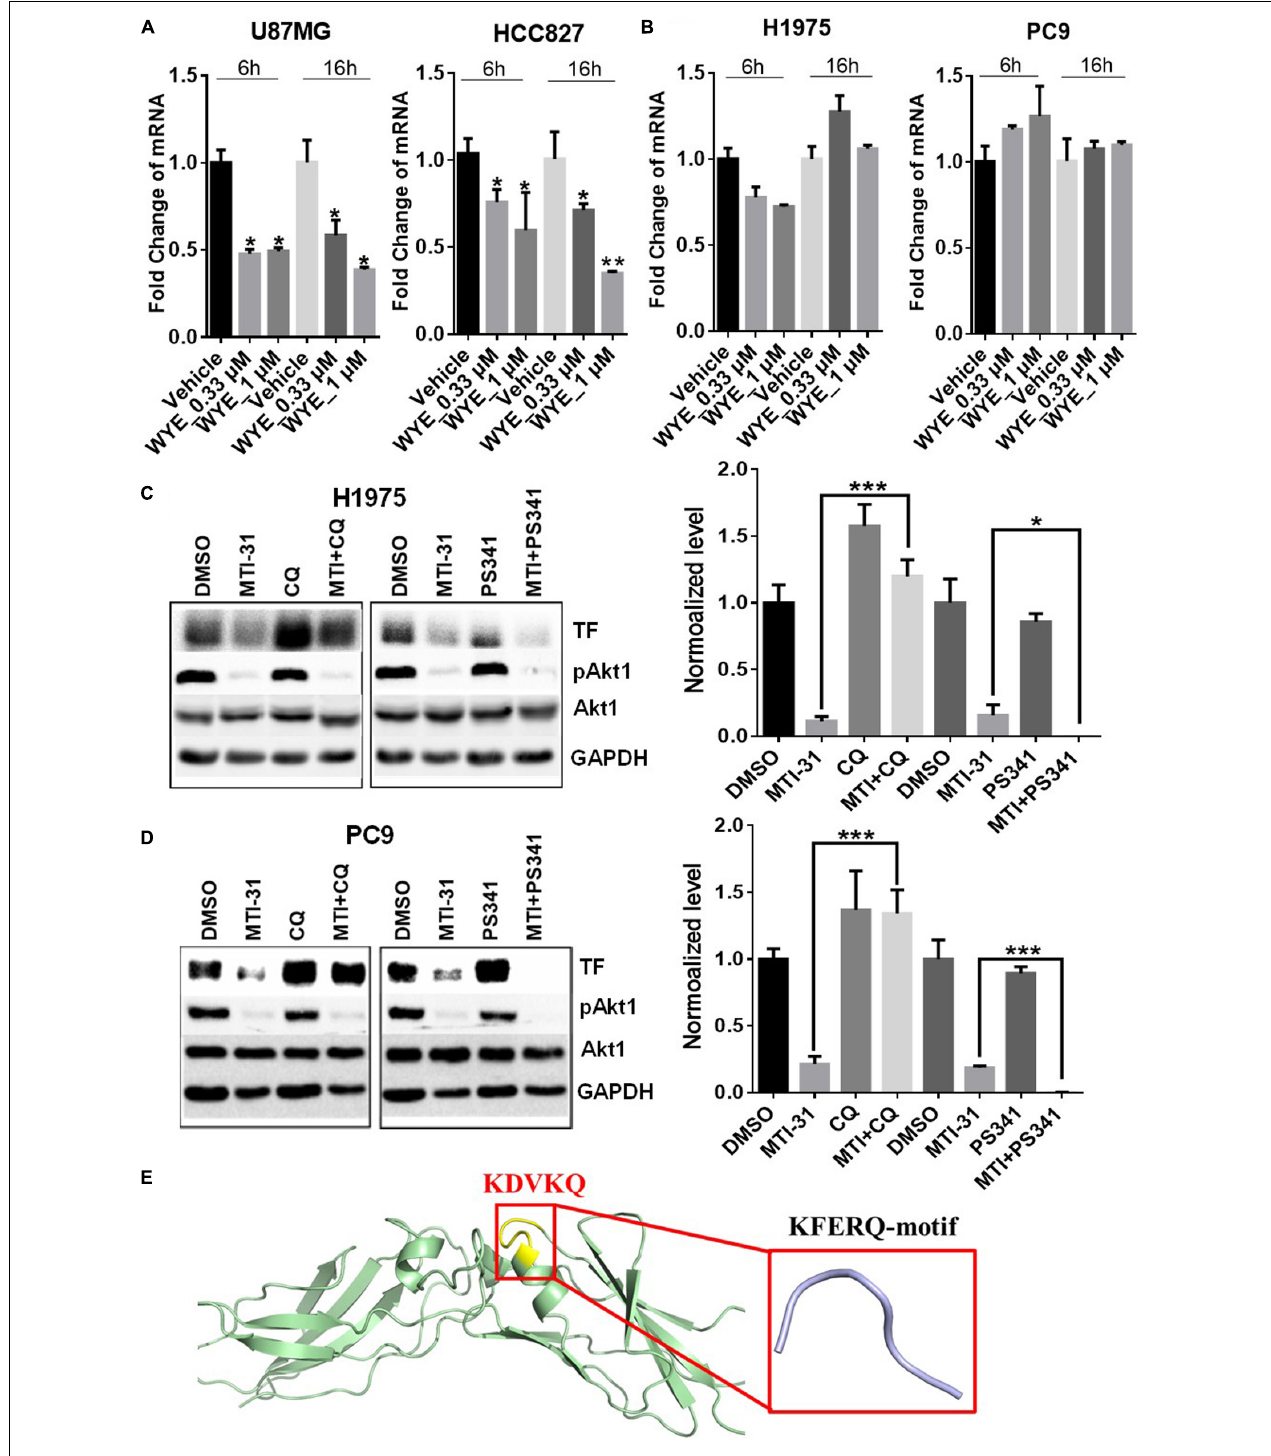
FIGURE 3 | Mechanistic target of rapamycin (mTOR) inhibitor differentially targets TF-mRNA transcription or TF protein degradation in a cellular context-dependent manner. (A,B) U87MG and HCC827 (A) , H1975 and PC9 (B) cells were treated as indicated, subjected to qPCR analysis of TF mRNA as described in section “Materials and Methods.” The relative mRNA levels are shown. (C,D) H1975 (C) and PC9 (D) cells were treated with 5 µ mol/L MTI-31 alone or in combination with 10 µ mol/L CQ or 0.01 µ mol/L PS-341 for 24 h, then immunoblotted (left panels) and quantified (right panels). * P < 0.05; ** P < 0.01, *** P < 0.001. (E) The amino acid sequence of TF was download from https://www.ncbi.nlm.nih.gov/to set up the model of TF structure using Pymol software. The KFERQ-motif is marked in yellow and its sequence is marked in red.